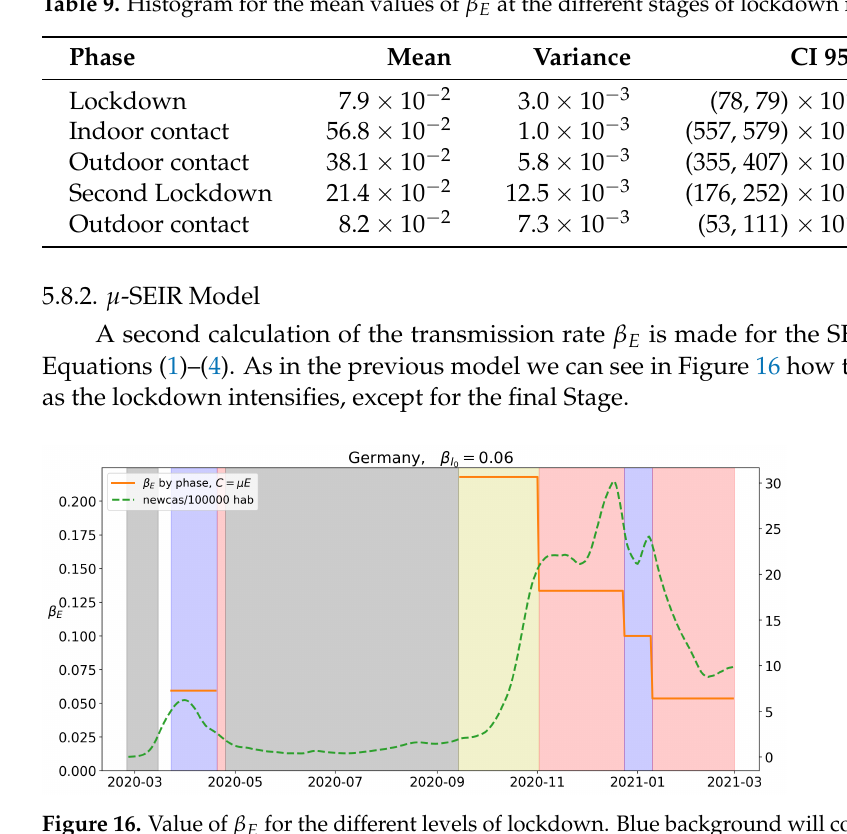
Figure 16. Value of β E for the different levels of lockdown. Blue background will correspond to Stage 1, red to Stage 2, yellow to Stage 3 and white to Stage 4. A green dotted line corresponds to the value of new cases per 100,000 hab.